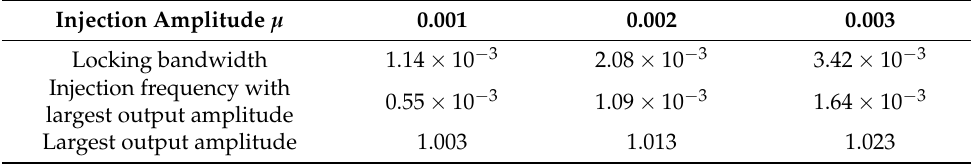
Table 3. Comparison of injection locking in different ripples.